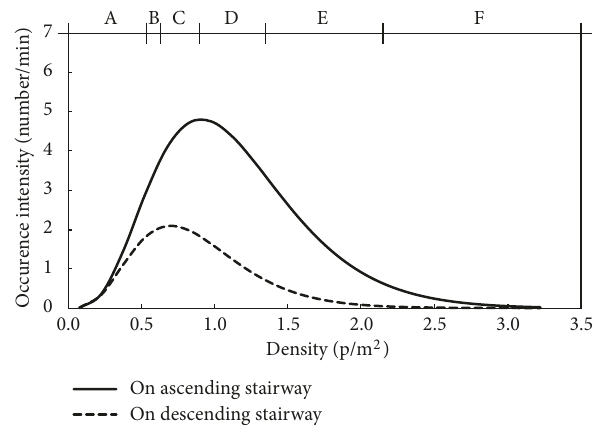
Figure 8: Fitting curves between occurrence intensity and pedes- trian flow